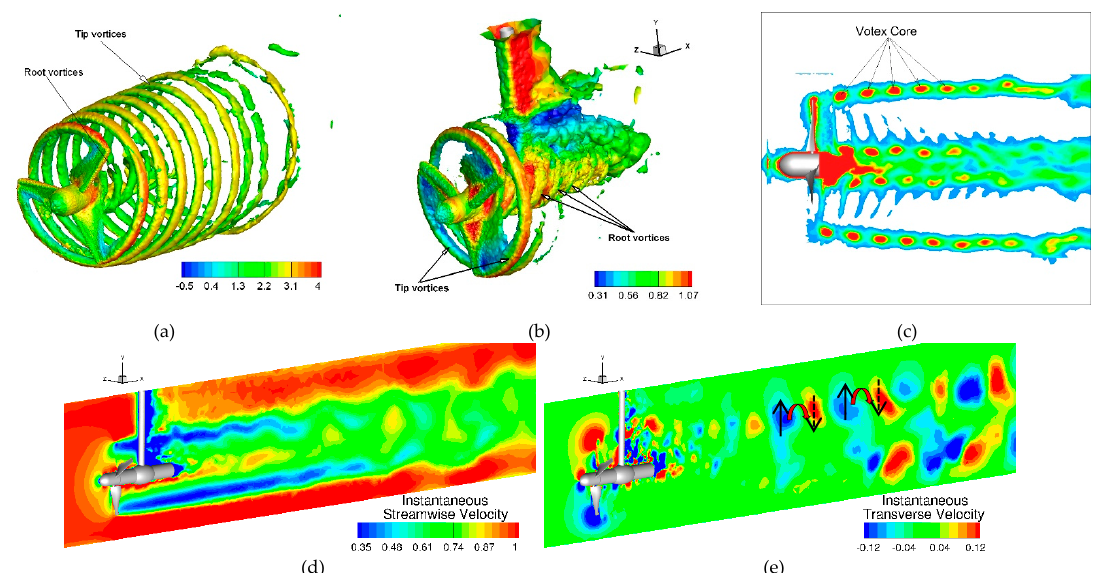
Figure 9. Wake flow pattern predicted by IDDES using Ansys/Fluent. Vorticity structure predicted for tidal stream turbine (TST) ( a ) w/o stanchion and ( b ) w/stanchion are shown using vorticity magnitude | ω | = 15. The vortices are colored using streamwise velocity. ( c ) Contour of plane normal vorticity magnitude at y/D = 0 plane for TST w/o stanchion. Instantaneous ( d ) streamwise ( x ) and ( e ) transverse ( y ) velocity contours in the wake predicted for TST w/stanchion. The sub-figure (e) shows that the alternate +ve and –ve spanwise velocities are due to passage of counter-clockwise vortices ω z .